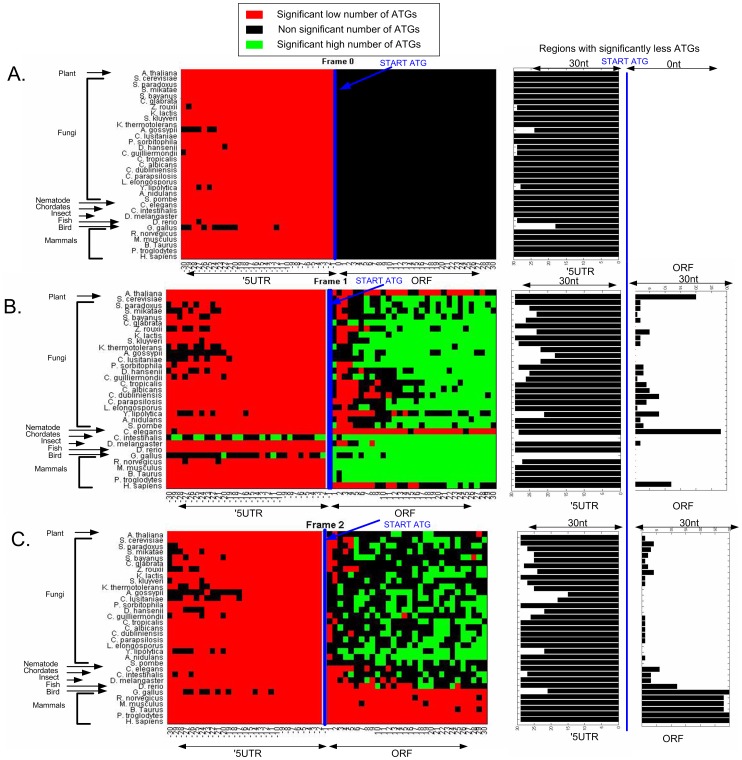
A–C. Genomic profiles of number of ATGs in the first thirty codons prior to, and following the START ATG, in comparison to 20 randomized genomes that maintain the amino acid order of each gene, the genomic GC content and codon usage bias, in the three frames (each sub-figure is related to one frame, A. Frame 0, B. Frame 1, C. Frame 2) for 33 eukaryotes (each row is one organism; each position within a row is related to a specific coordinate of the ATG codon before (5′UTR) or after the beginning of the ORF; Methods).Left part: There are three possible colors: Red – denotes cases where in that position the random genome includes significantly more ATGs than the real genome; green – denotes cases in which in that position the random genome includes significantly less ATGs than the real one; black – denotes that the random and real genomes are not significantly different in that position. Right part: the regions (5′UTR and ORF) of significantly lower number of ATG codons relatively to the randomized genomes for each organism and each frame (Methods). In all frames, the number of ATG codons in the 5′UTRs is significantly lower than expected. In frame 1 and 2 (according to our randomization frame 0 is identical in the random and real genome) the number of ATGs in most of the organisms is significantly lower in the first five codons. See Supplementary Figure S34 for permuted randomization (Methods).